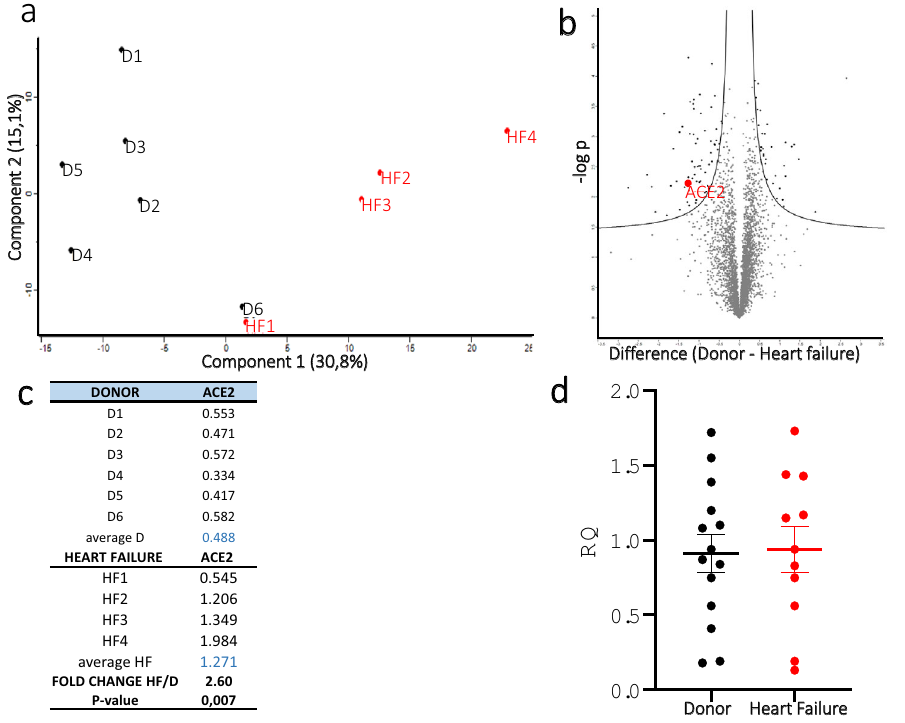
Figure 2. Quantitative proteomics and gene expression of ACE2. (a) Principal component analysis (PCA) of the D = Donor and HF = Heart Failure groups based their proteomic expression files. The first and second components segregate the groups and account for 30.8 and 15.1% of the variability, respectively. (b) Vulcano plot of al included proteins showing that ACE2 was one of the proteins that was overexpressed in the HF group. (c) Abundance ratios from TMT quantification where sample abundances are divided with reference abundance. ACE2 was upregulated 2.6 × with a p value of 0.007 (Two-sided student t test) in the HF group. (d) RT-qPCR relative quantification of the gene expression of ACE2 based on RNA from left ventricular tissue from 14 organ donors and 11 HF patients. There was no difference in ACE2 gene expression between the